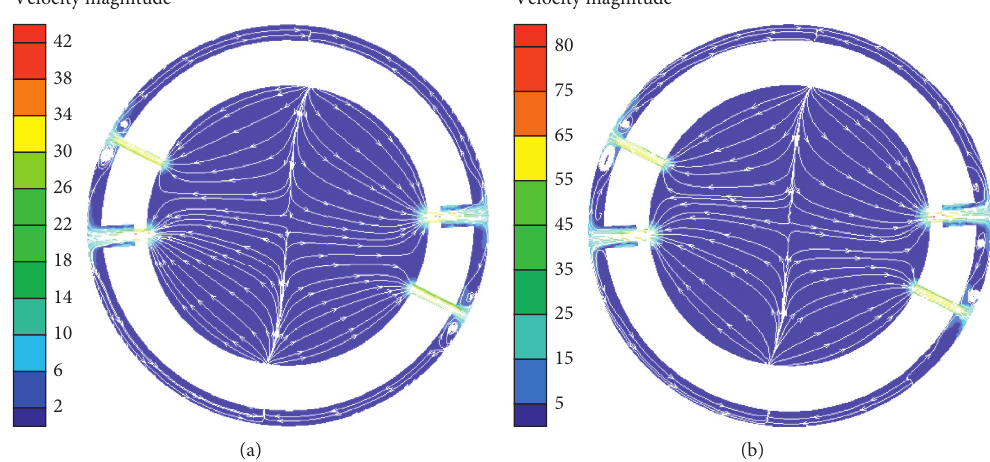
Figure 7: Velocity distribution contours at a cross-section of the damping valve in compression stroke at (a) t � 0.05s and (b) t �